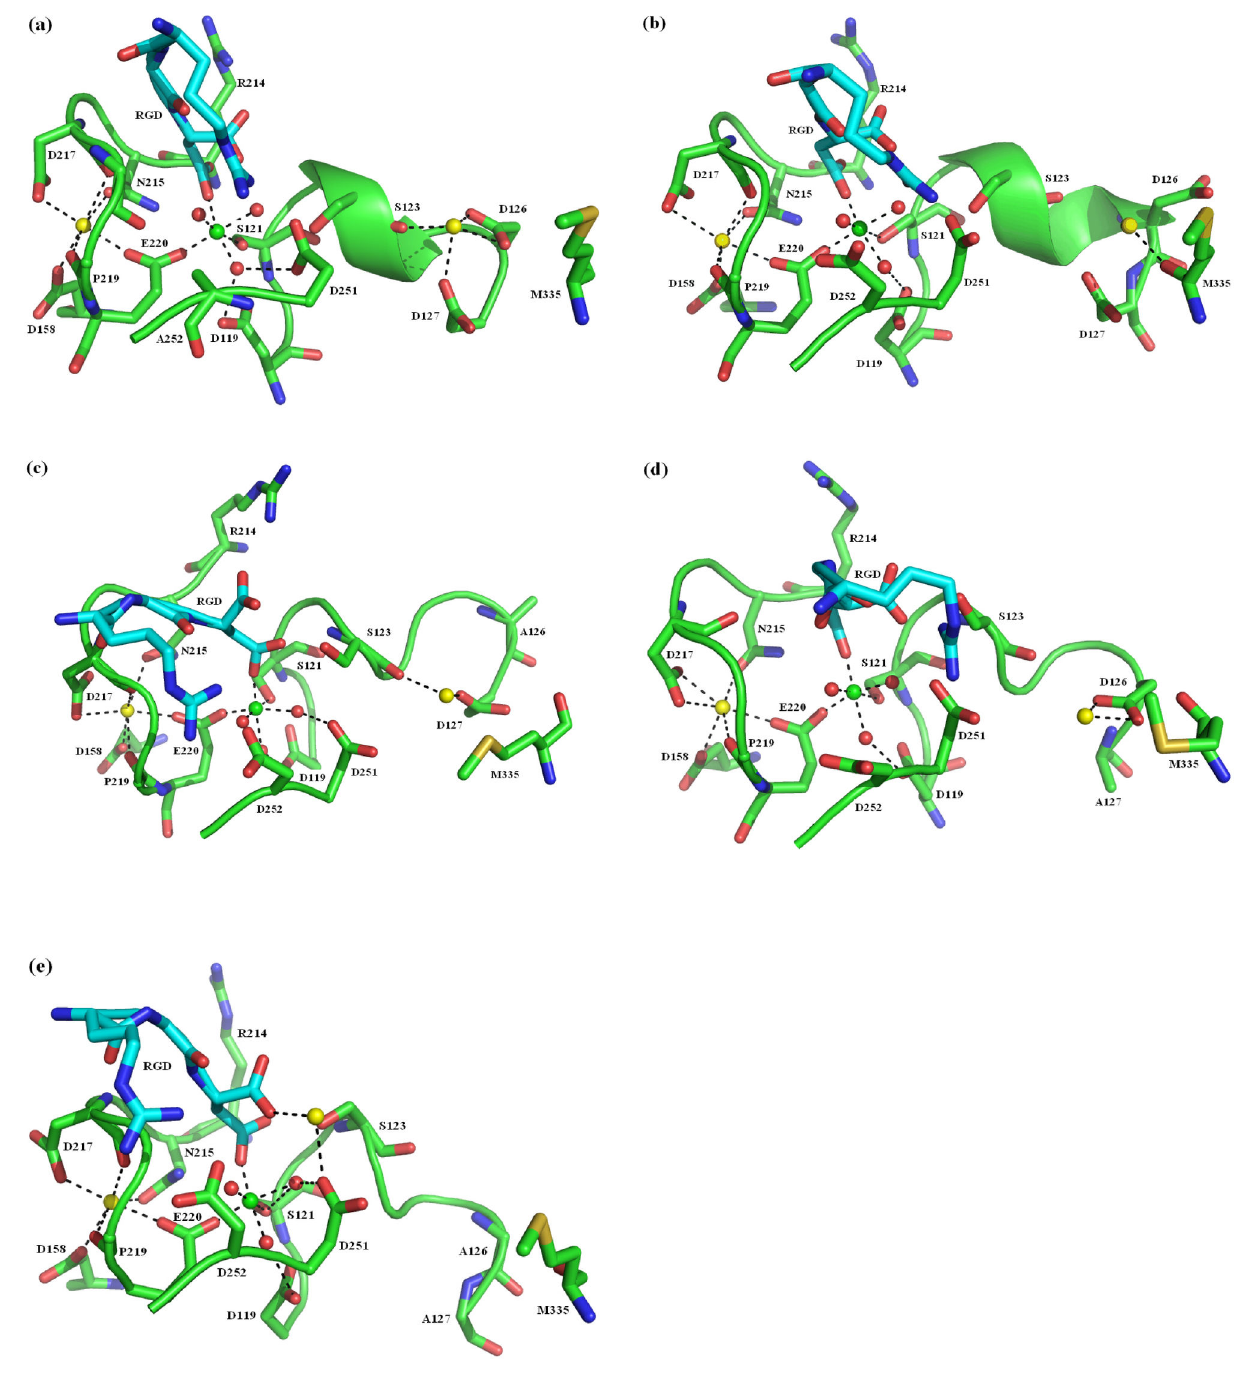
Figure 6. The view of the RGD binding site. Final snapshots of the RGD binding site in (a) wild-type (WT) and mutant (b) A252D, (c) A252D/D126A, (d) A252D/D127A, (e) A252D/D126A/D127A from the molecular dynamics simulations in Mg 2+ -Ca 2+ -Ca 2+ state. Ligand is shown in stick and colored cyan. N and O atoms involved in metal coordinating are colored in blue and red, respectively. Mg 2+ is green, Ca 2+ ions are yellow, and coordinating water molecules are red. Polar coordination between O atoms and metal ions are shown by dashed black lines.